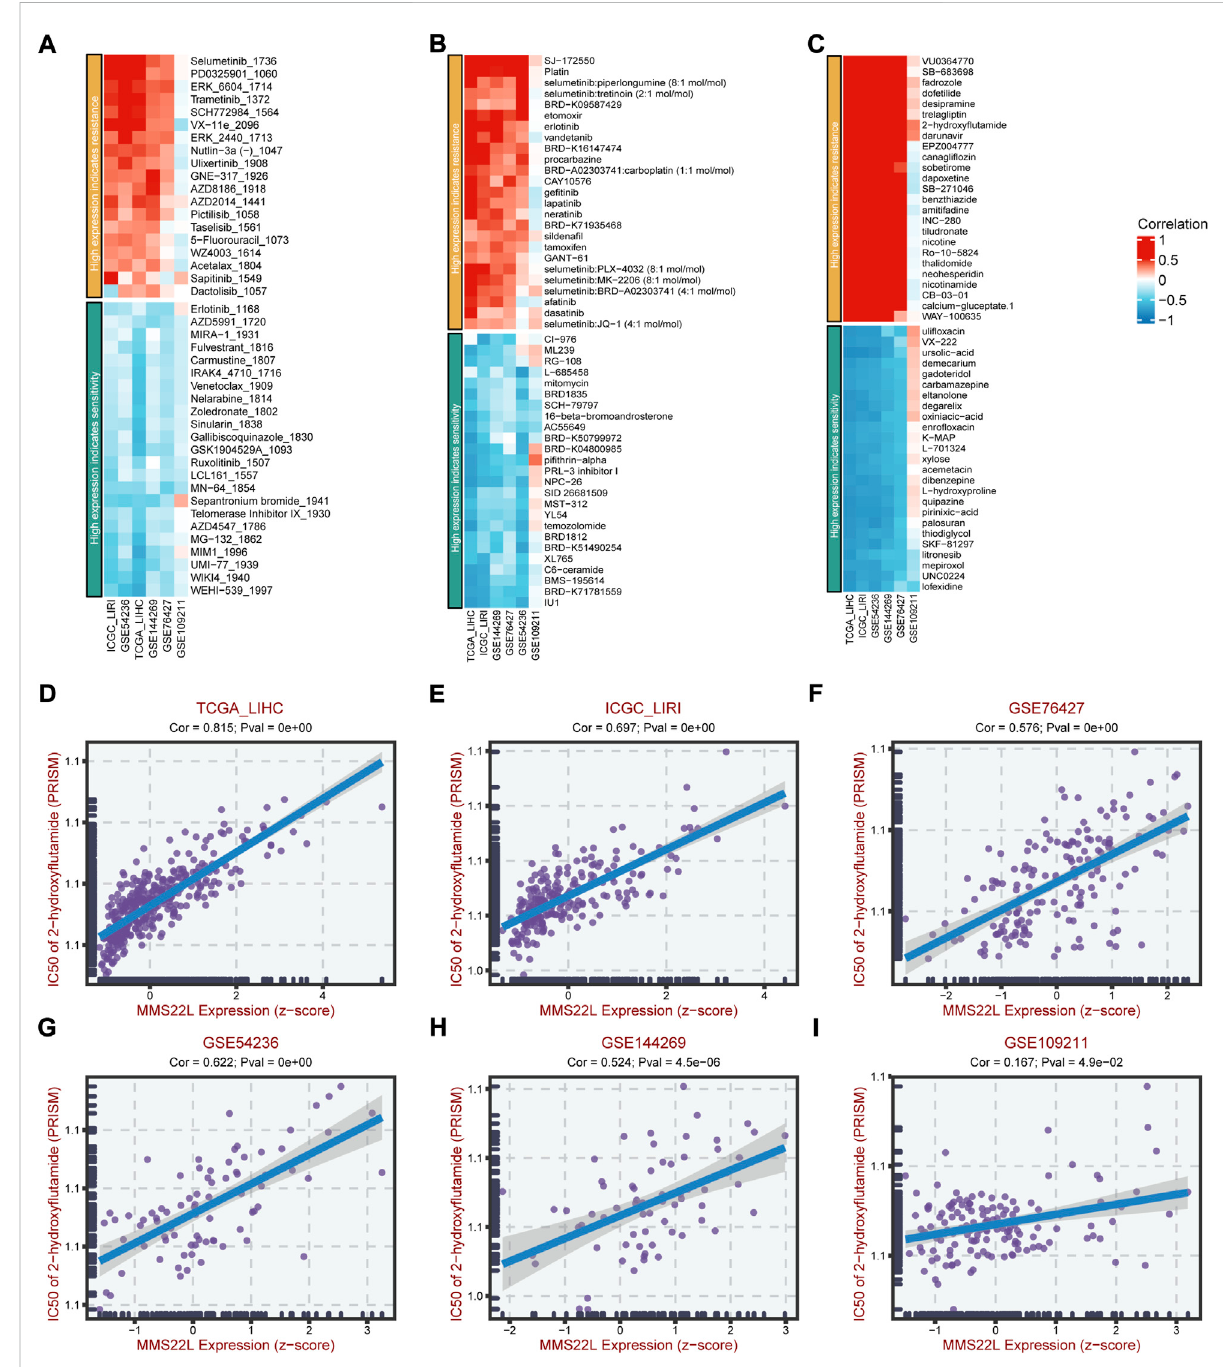
FIGURE 9 The association of methyl methanesulfonate-sensitivity protein 22-like (MMS22L) expression with drug sensitivity in hepatocellular carcinoma (HCC). (A) Relation of MMS22L expression with drug sensitivity in multiple HCC cohorts according to the GDSC2 database. (B) Relation of MMS22L expression with drug sensitivity in multiple HCC cohorts according to the CTRP database. (C) Relation of MMS22L expression with drug sensitivity in multiple HCC cohortsaccording to thePRISM database. (D – I) The correlation ofMMS22Lexpression and 2-hydroxy fl utamide sensitivity (IC50) in TCGA-LIHC (D) , ICGC-LIRI (E) , GSE76427 (F) , GSE54236 (G) , GSE144269 (H) and GSE109211 (I) according to the PRISM